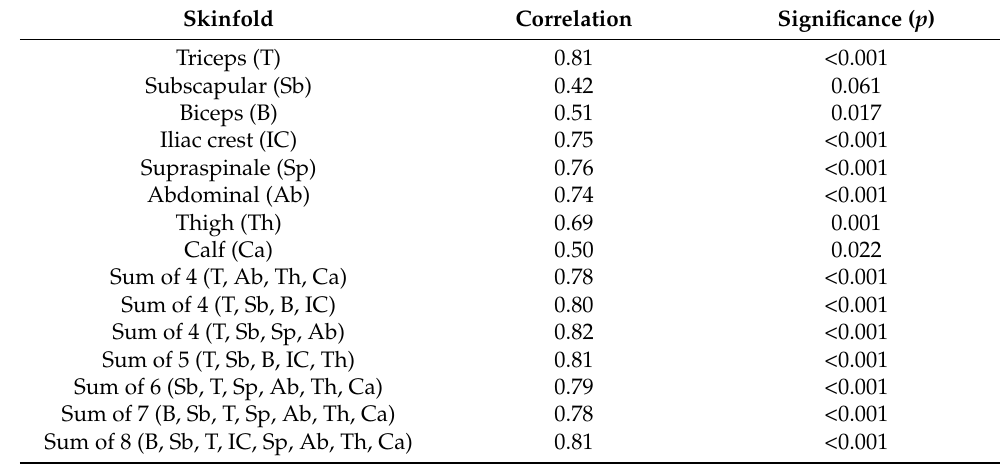
Table 3. Relationship between DXA-derived % body fat values and those derived from different skinfold measurements or the sum of several skinfold measurements in elite male soccer players ( n = 21). Skinfold